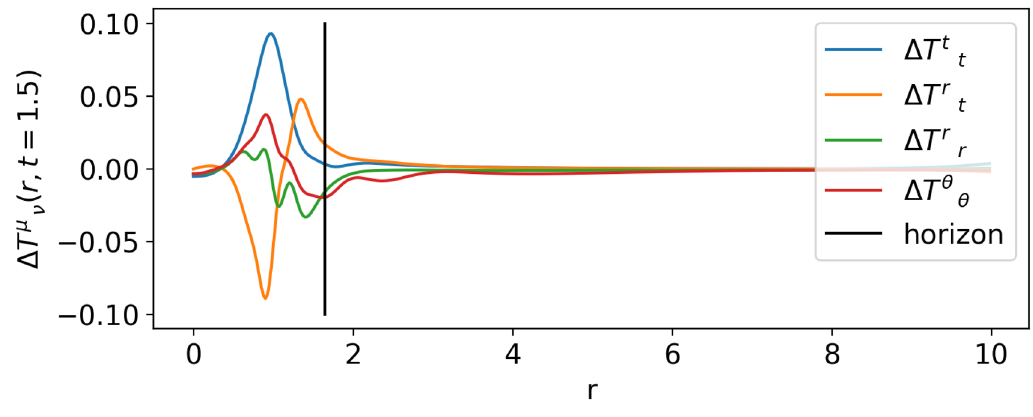
Figure 4 . Quantum corrections for the stress-energy tensor components T µ ν , defined by ∆ T µ ν = h χ | ˆ T µ ν | χ i − T µ (with T µ from the classical collapse) at t = 1 . 5 ( c ) ν ( c ) ν